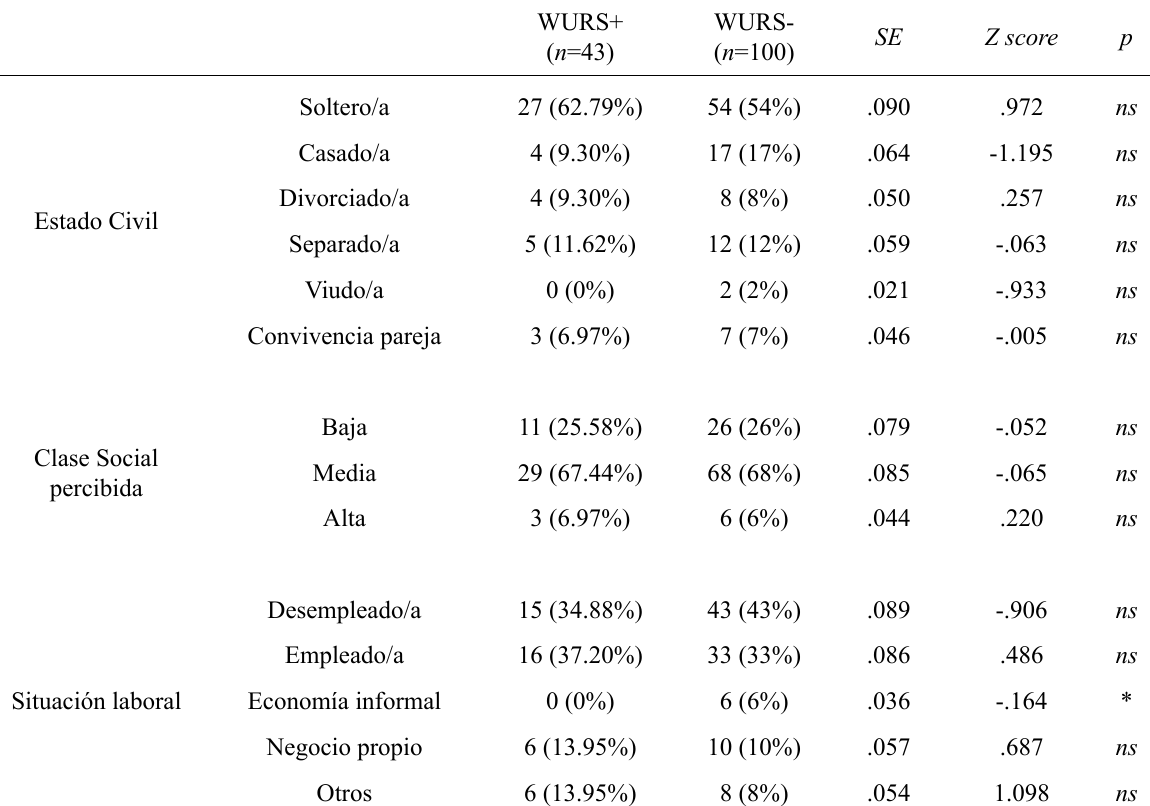
Características de los Carcelarios por Estado Civil, Clase Social y Situación Laboral según el Resultado del